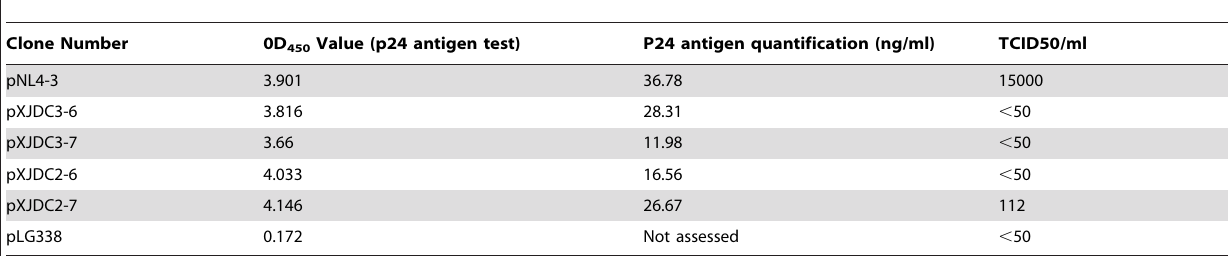
Table 2. P24 antigen production and TCID 50 /ml of supernatant from plasmid transfected 293T cells.